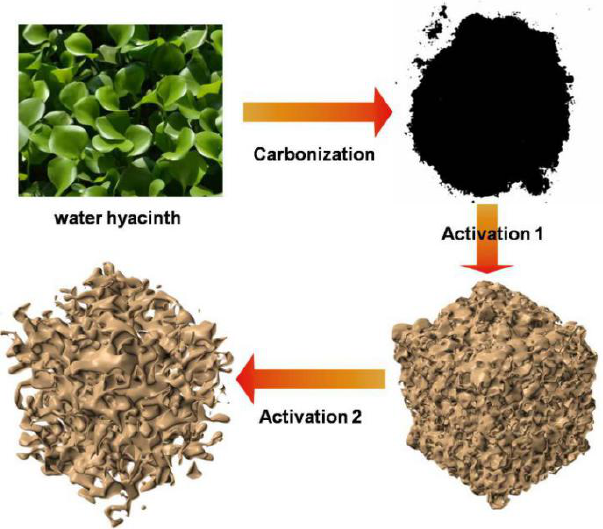
Figure 1. The scheme of the preparation process.